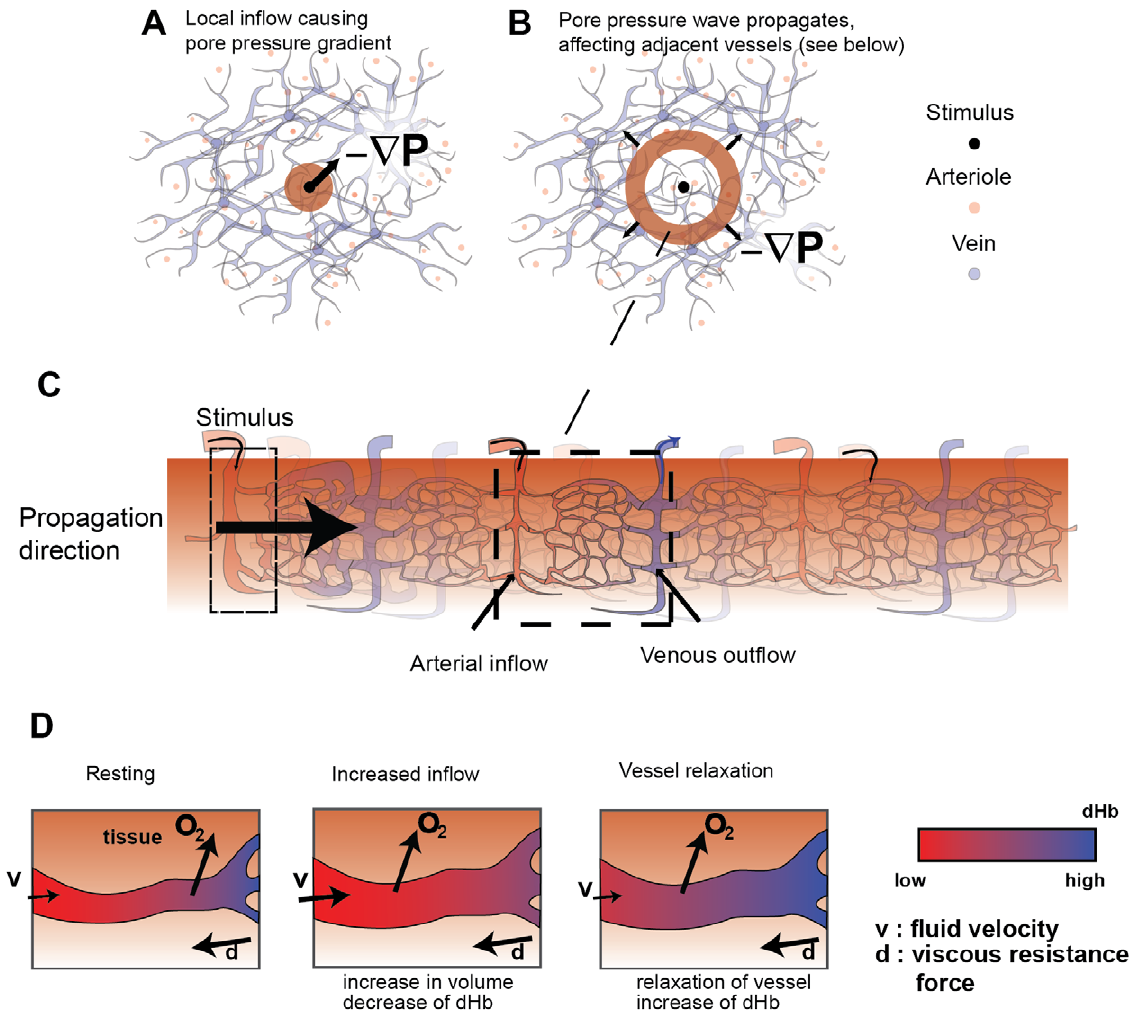
Figure 1. The spatiotemporal hemodynamic model. A: The hemodynamic response is driven by a localized spatiotemporal input, which represents neural activity and causes a change in arterial inflow of blood, which sets up a pressure gradient = P. B: This mass inflow deforms surrounding tissue and thus exerts pressure on nearby vessels. C: The rise in pressure causes further volume changes in adjacent vessels, which propagate outwards via interactions with successive regions of tissue. Damping of the response through blood viscosity and losses via outflow. D: The increase of local inflow increases oxygenated hemoglobin (oHb), reducing the amount of local deoxygenated hemoglobin (dHb). As oxygen is simultaneously passively extracted from blood, oHb is converted to dHb, causing a delayed rise of dHb during vessel relaxation.